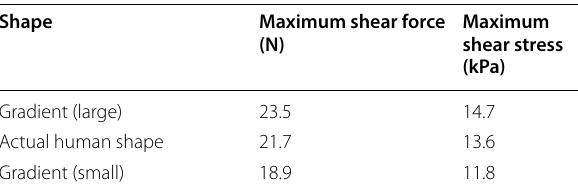
Table 2 Maximum shear forces and